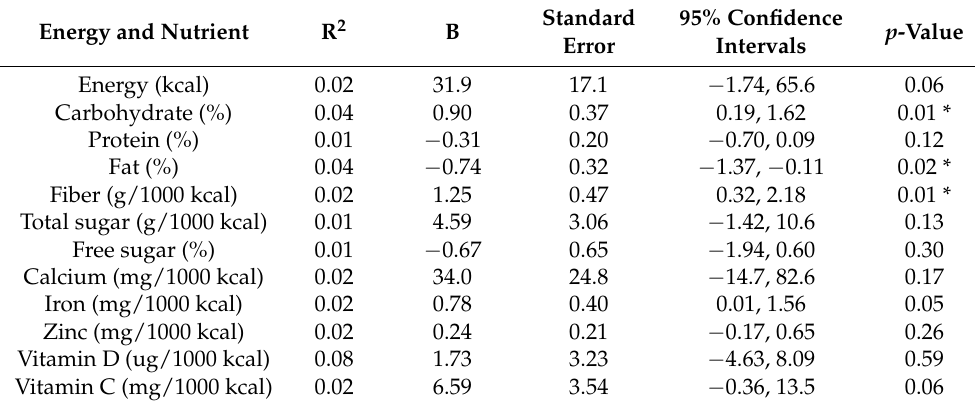
Table 3. Multiple linear regression analyses of maternal use of pressure to eat on energy and nutrient intakes of children a .